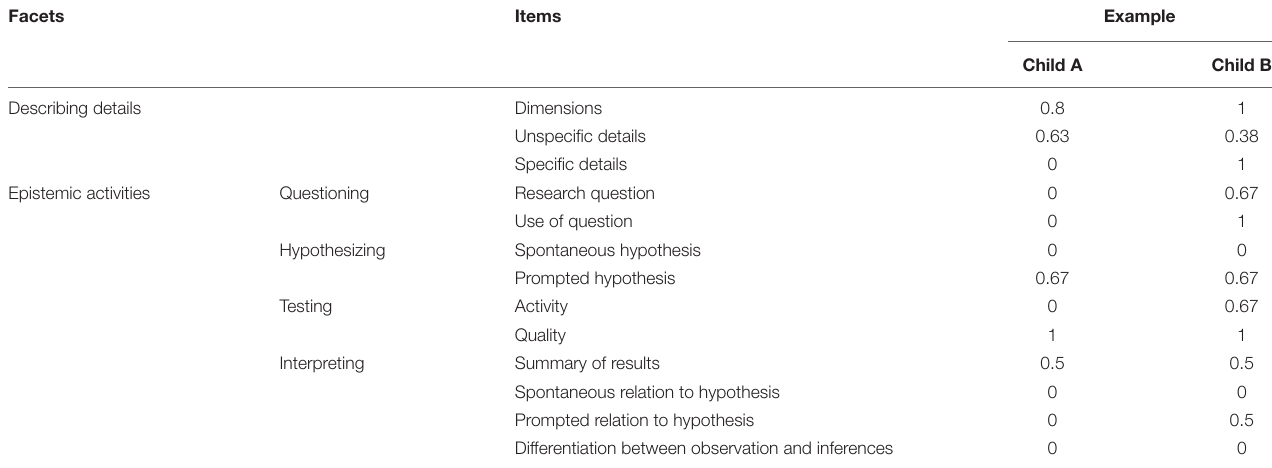
TABLE 2 | List of items measuring observation competency. Facets